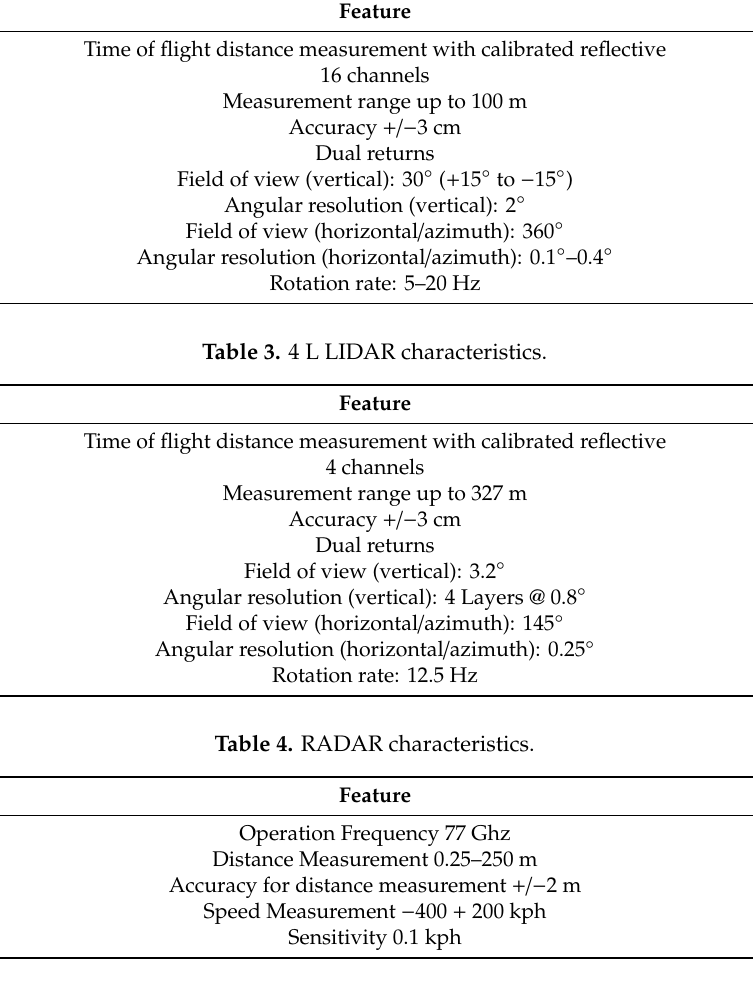
Table 5. Trifocal camera